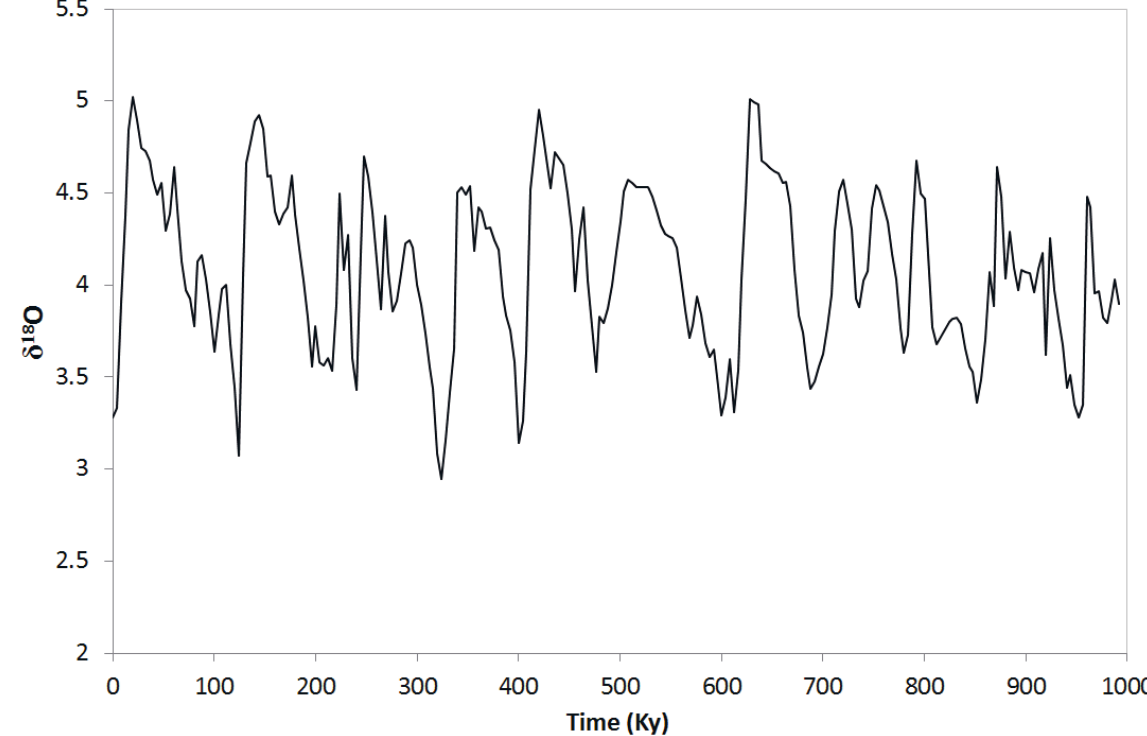
Figure 6. Real time series of (cid:2012) (cid:2869)(cid:2876) O of the DSDP607 series with 249 data and a sampling constant interval of 4 kiloyears